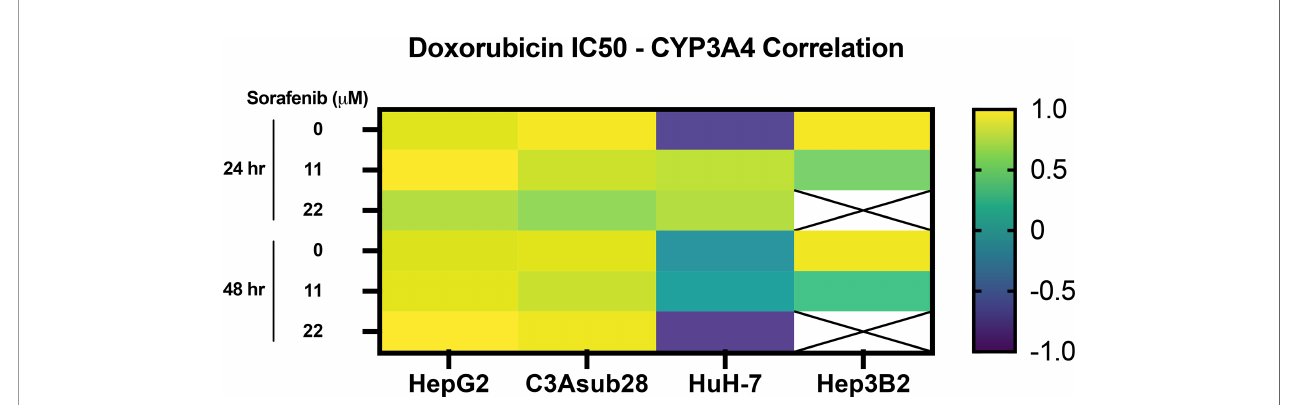
FIGURE 6 | Pearson correlation between CYP3A4 expression and doxorubicin IC 50 fi ndings with and without the in fl uence of sorafenib treatment in 3D culture conditions. Strong correlation was observed in CYP3A4 expressing HepG2 and C3Asub28 cells unlike to HuH-7 and Hep3B2. Array cells with cross represent IC 50 values were not detected within